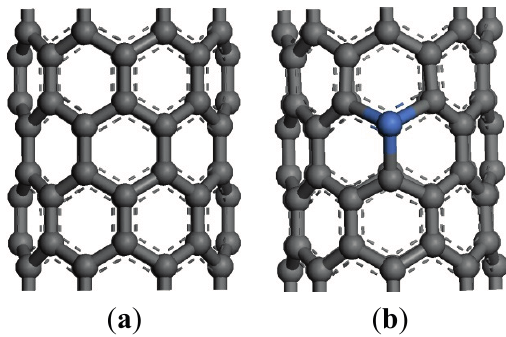
Figure 6. Structural model of CNTs and Ni-CNTs. ( a ) CNTs; ( b ) Ni-CNTs.